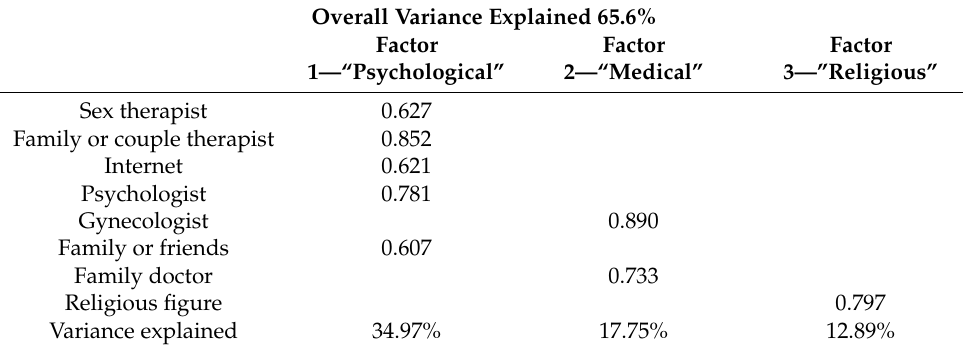
Table 5. Factor analysis of appropriate sources for